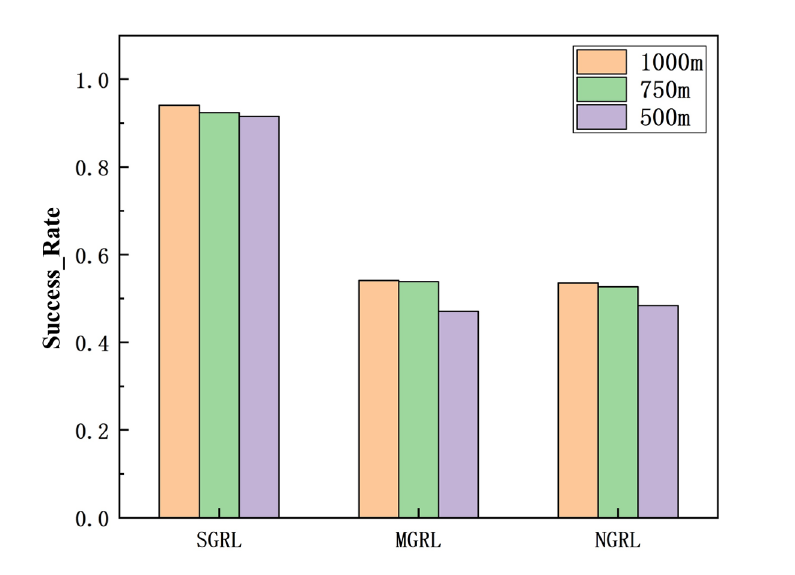
Figure 22. Diagram of testing success rate. This value is obtained by the ratio of the number of vehicles completing the task (entering the corresponding ramp) to the total